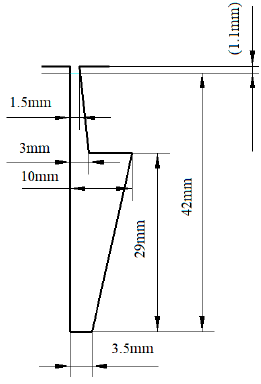
Figure 4. Dimensions of the rotor slots.